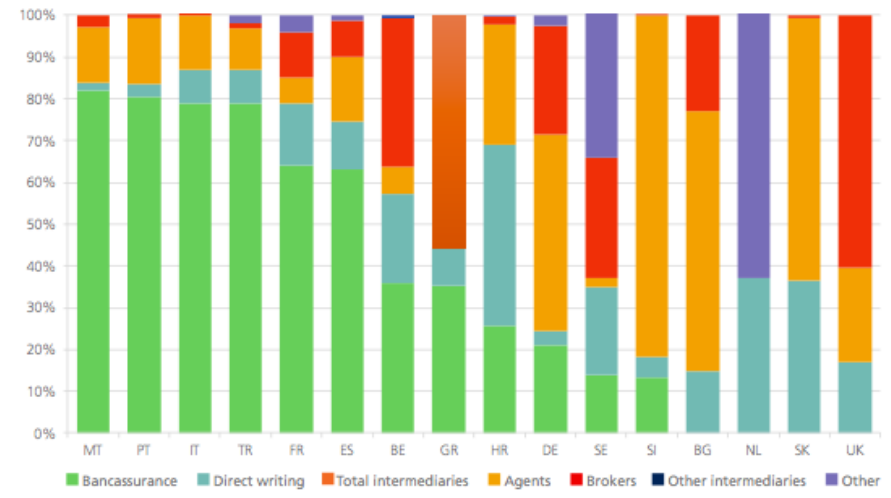
Fig. 1. Life distribution channels in 2014 (% of GWP) Source: Insurance Europe (2016, p. 43).